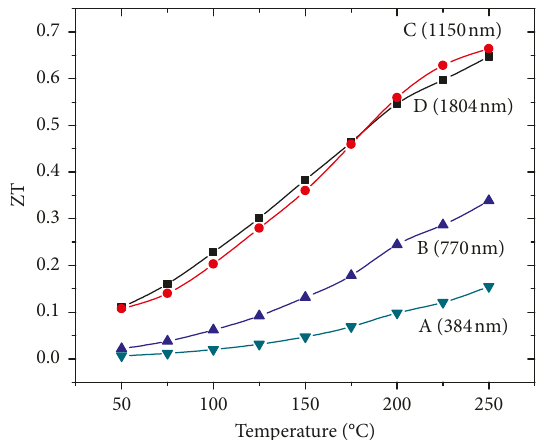
Figure 9: Calculation of ZT for Sb measuring